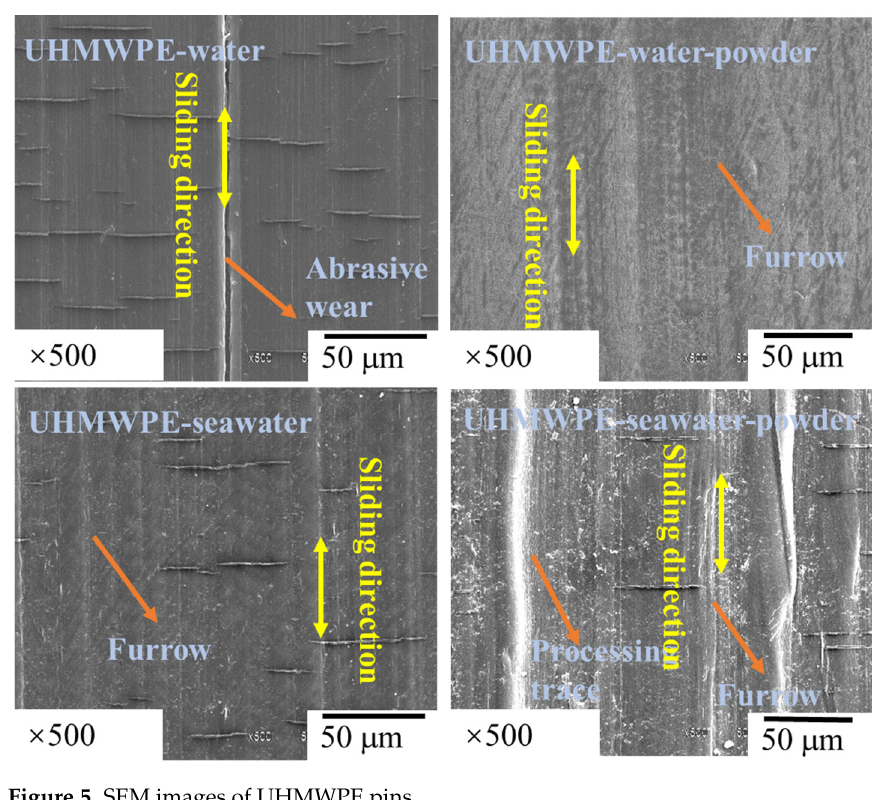
Figure 5. SEM images of UHMWPE pins.